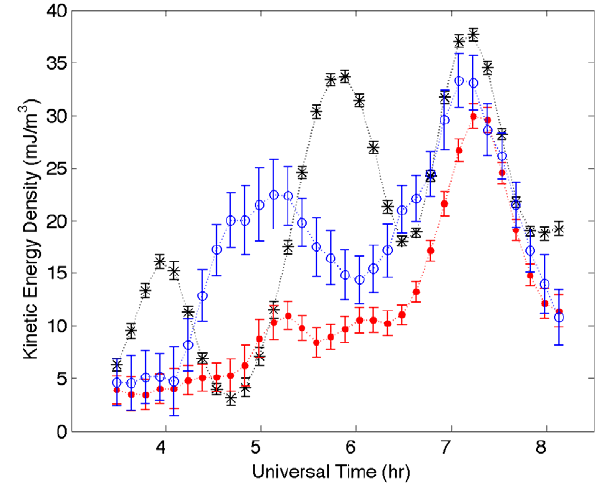
Fig. 3. Kinetic energy density on 15 August 1999 in the same for- Figure 3. Kinetic energy density on August 15, 1999 in the same format as Figure 1. Potential mat as Fig. 1. Potential energy per unit mass (J/kg) can be found energy per unit mass (J/kg) can be found by multiplying the KED by: 2.3 (Low), 0.46 (Middle) by multiplying the KED by: 2.3 (Low), 0.46 (Middle) and 0.052 (High). and 0.052 (High).